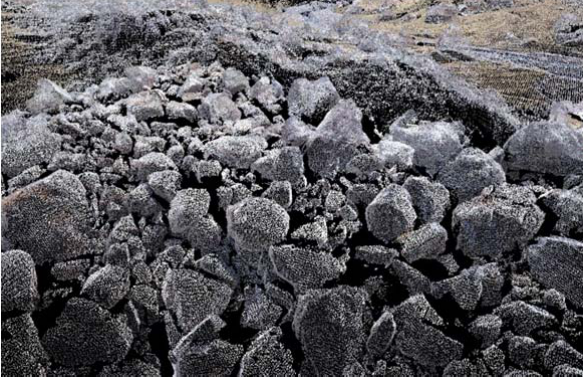
Figure 4: Coloured Point Cloud in Cyclone